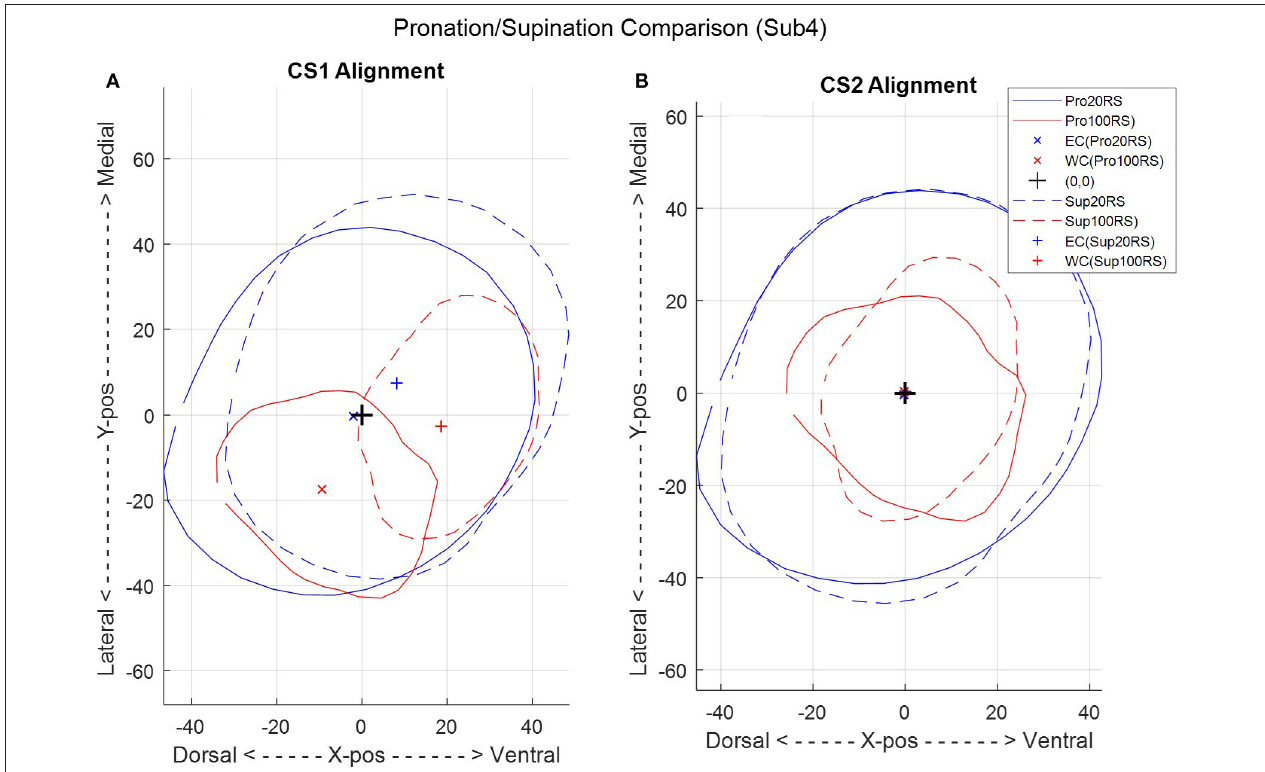
FIGURE 9 | A comparison between the two combined-subject ellipse-fit models, CS1 (A) and CS2 (B) , for a single subject (subject 4) in pronation (Pro) and supination (Sup) at 20 and 100% radiale-stylion (RS) length from the radiale